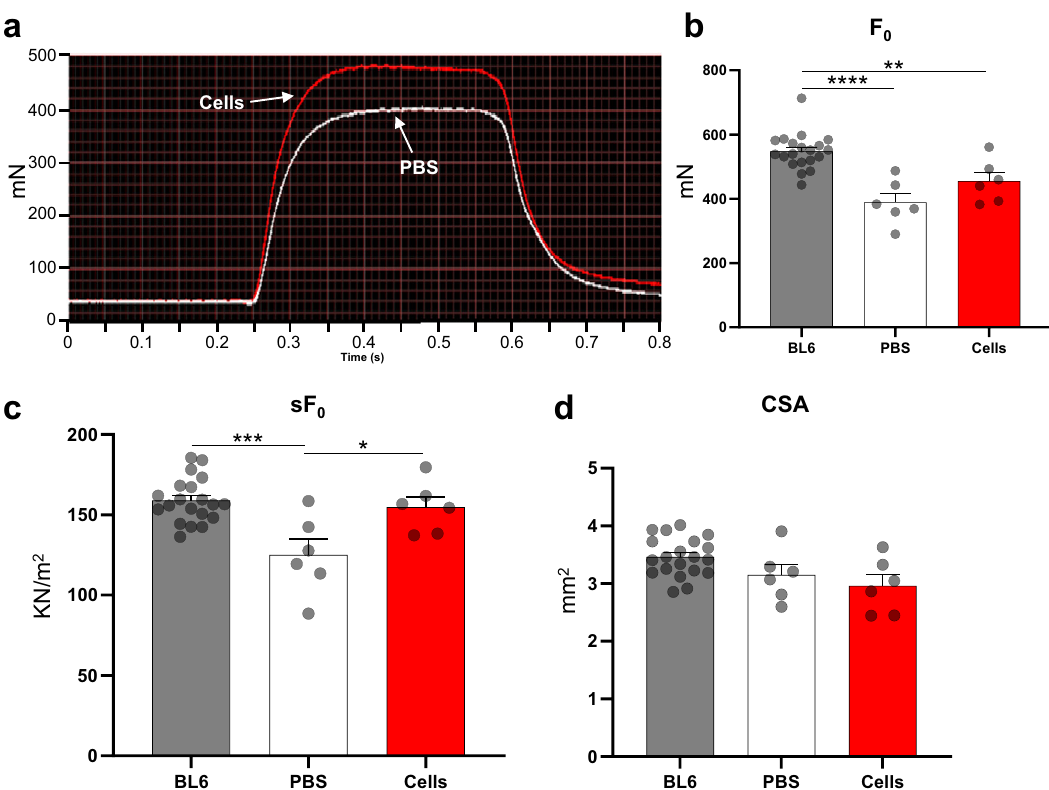
Fig. 5 Effect of cell transplantation on the muscle contractile properties of iDUX4pA-HSA mice. a Representative example of force tracing upon tetanic stimulation in TA muscles from iDUX4pA-HSA mice. Red and white lines show force tracing from muscles that had received cell transplantation or PBS, respectively. b , c Effect of cell transplantation on b absolute ( F 0 ) and c speci fi c (s F 0 : F 0 normalized to CSA) force. Control BL6 mice were used as reference. Data are shown as mean ± SEM ( n = 20 for BL6, n = 6 for PBS and cells). * p < 0.05, ** p < 0.01, *** p < 0.001, **** p < 0.0001 by the Student ’ s t test. d Average CSA of analyzed muscles (from b , c ). Data are shown as mean ± SEM. ** p < 0.01 by the Student ’ s t